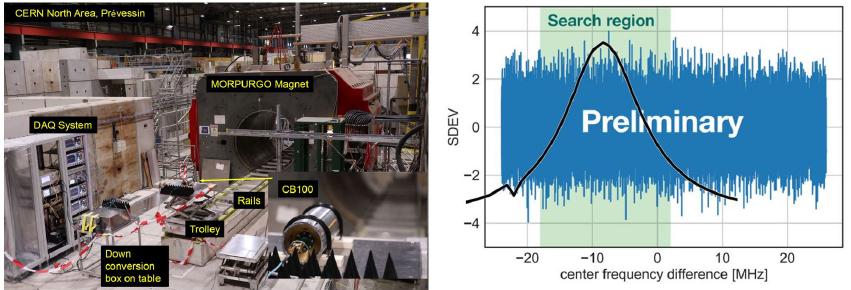
Figure 5. Left: CB100 setup including receiver and DAQ at CERN in front of the MORPURGO magnet before insertion. Right: Background measurement with the receiver and DAQ system with CB100 connected and B-field on. The measured power is normalized to the noise level in terms of standard deviation. The black curve gives the shape of the power boost factor of CB100. The shaded area indicates the frequency range where the setup is sensitive due to the power